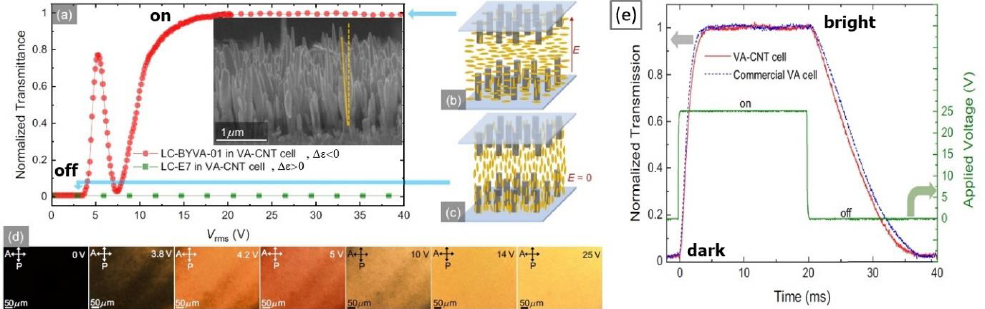
Figure 9. Electrooptic response of a vertically aligned liquid crystal device with nanotube electrodes and negative dielectric liquid crystal (LC). ( a ) Typical transmission versus voltage curve, due to the birefringence changes between crossed polarisers. The device is dark in the “off-state” and bright in the “on-state”. ( b , c ) Schematic orientation of the liquid crystal in the on- and the off-state, respectively. ( d ) The change in transmission between crossed polarisers as the negative dielectric liquid crystal responds to the applied increasing voltage. ( e ) Dynamic switching response of the cell with response times in the ms range for the electric field driven switching into the on-state, and in the 10s of ms range for the elastically-driven switching into the off-state. The response is similar for the nanotube electrodes as compared to a commercial cell. (Reproduced by permission from [116]).